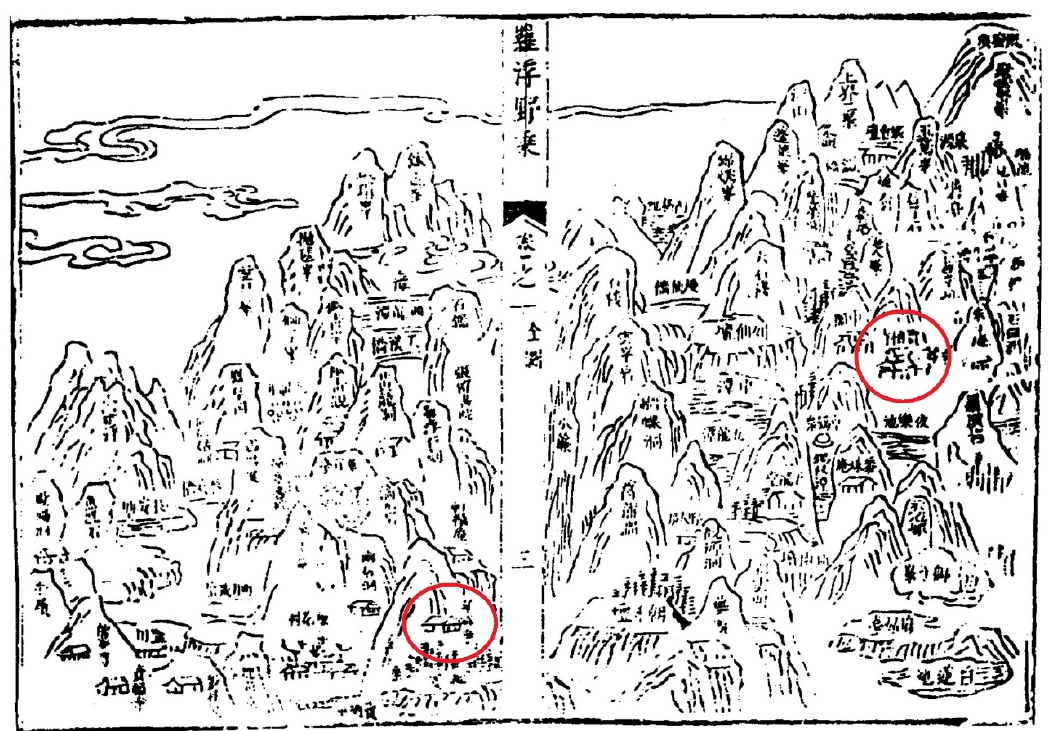
Figure 12. The Yanxiang Si (left) and Baoji Si in the panorama in Yesheng , 1639. Woodblock print. After Han Huang, Luofu yesheng , 1.2a-b (480).